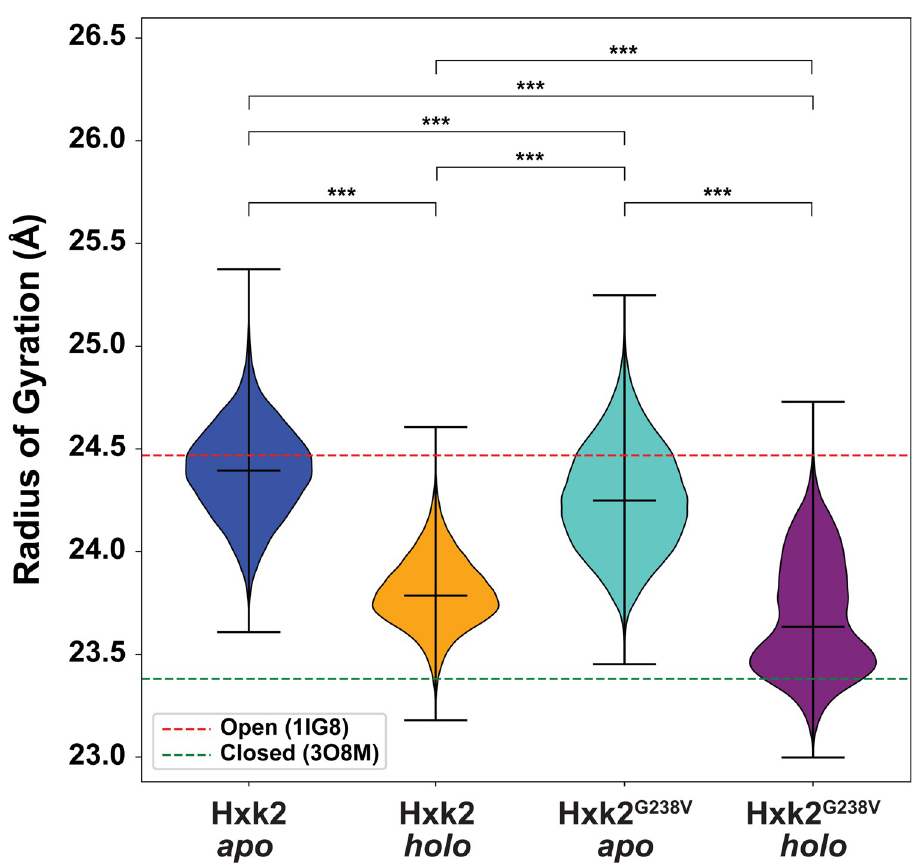
Fig 8. Distributions of the radii of gyration. For reference, the red and green dashed lines show the corresponding values of the 1IG8 ( Sc Hxk2, open) and 3O8M ( Kl Hxk1, closed) crystal structures, respectively. The middle horizontal lines correspond to the median values associated with each simulation. The mean of each simulation differs statistically from the means of all others (Kruskal–Wallis, p -value < 0.001; Conover post hoc analysis, adjusted p -value < 0.001 in all cases, indicated by ���